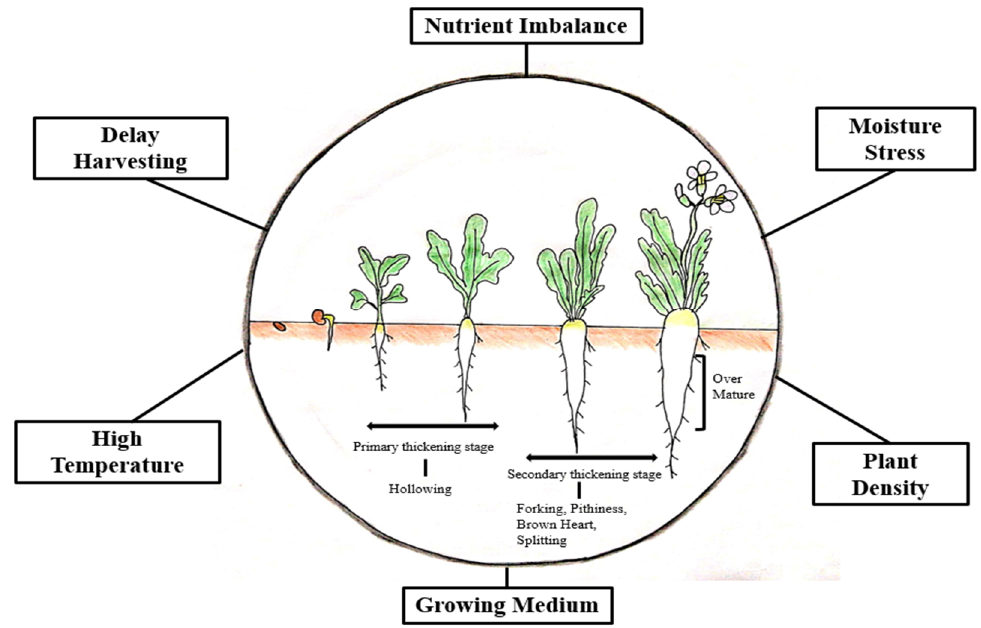
Figure 1. Abiotic factors induced physiological disorder in radish at different root development stages.